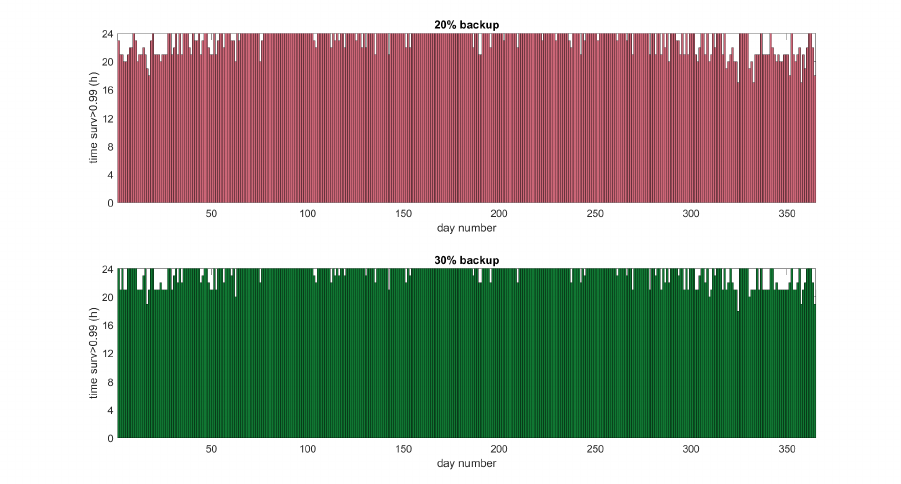
Figure 7. Number of hours per day that the survivability probability is at least 0.99 for a full year using the power-save strategy with 20% and 30% backup capacity,